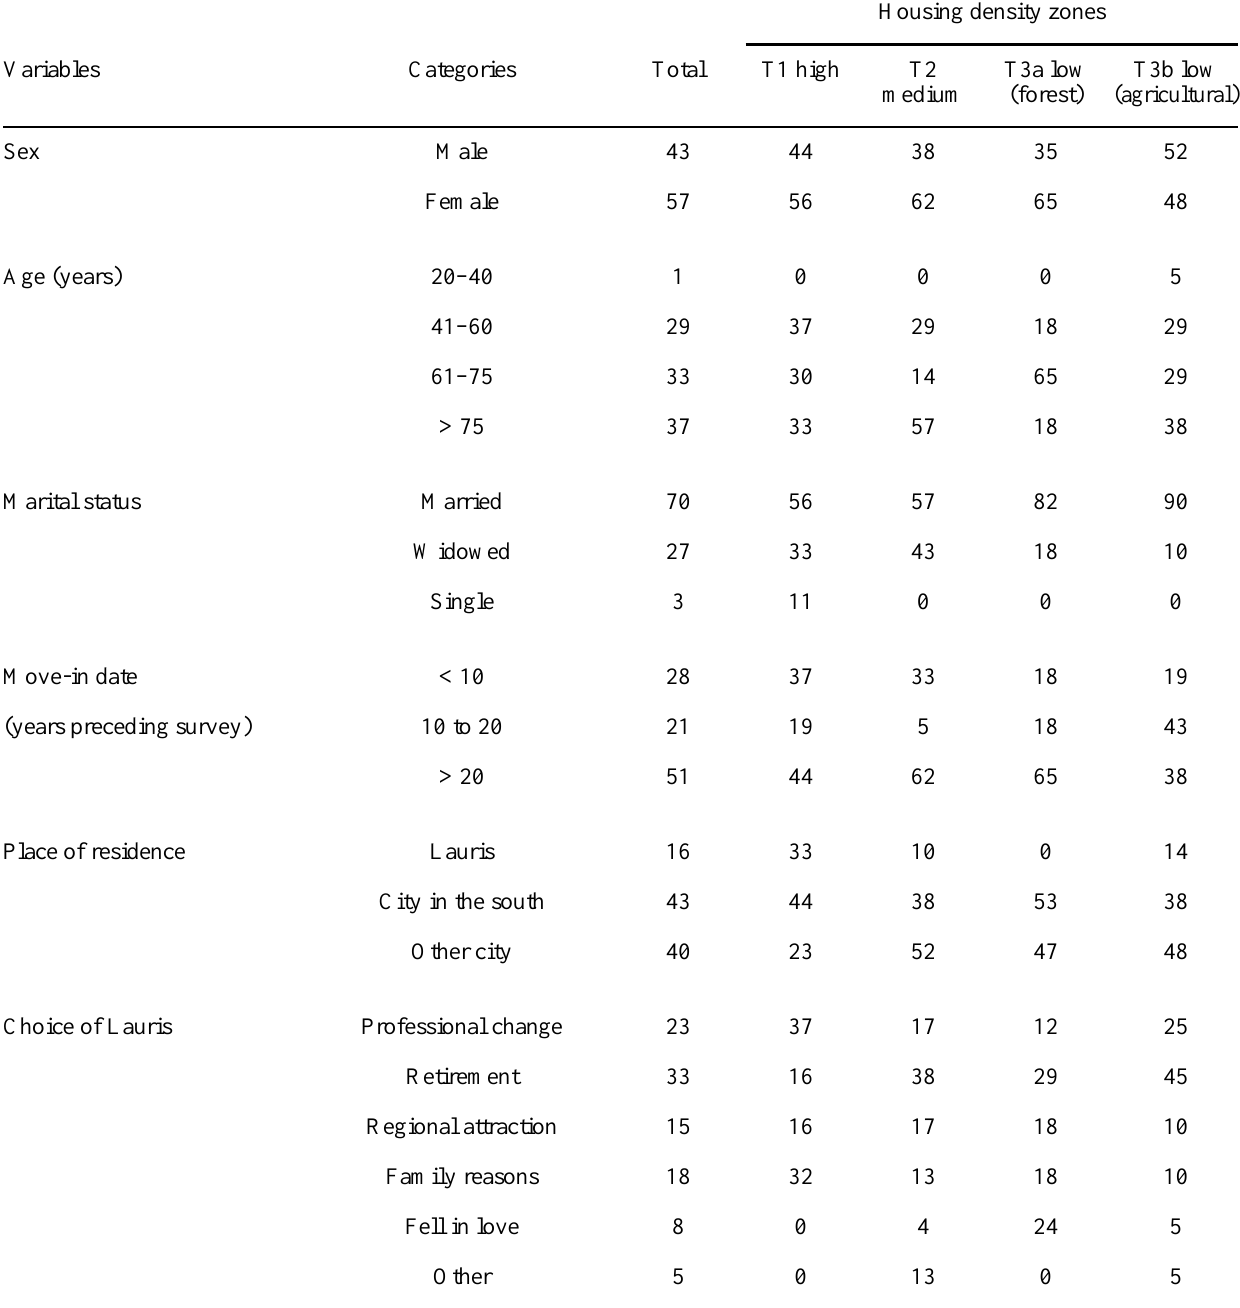
Table 1. Social determinants of Lauris gardeners by housing density zone (frequency in %). T1: high- density housing type (built-up area > 20%) corresponds to the center of Lauris; T2: medium-density housing type (built-up area 10–20%) corresponds to two residential areas close to the center; T3a and T3b: low- density housing type (built-up area <10%) corresponds to villas scattered in pine forest or built on fallow